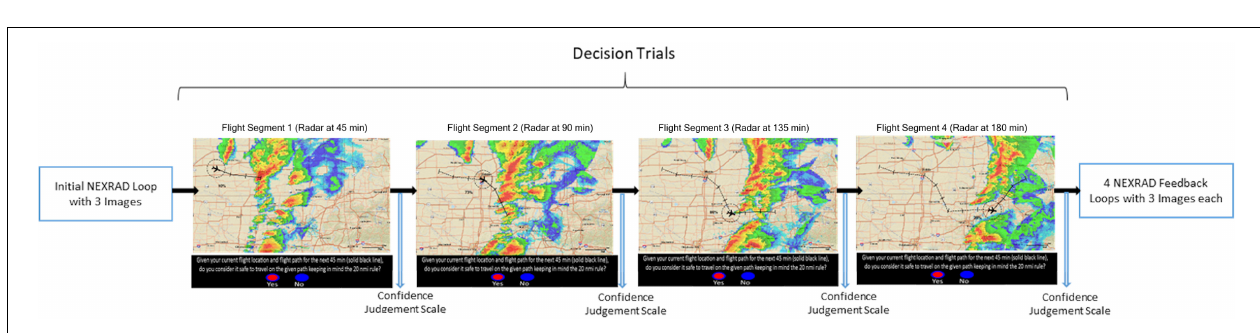
FIGURE 6 | Flow diagram of test phase